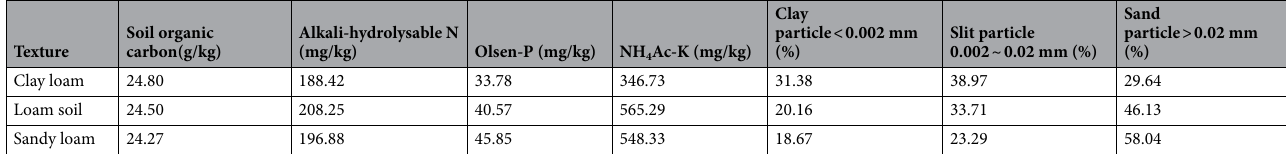
Table 1. Physical and chemical properties of different texture